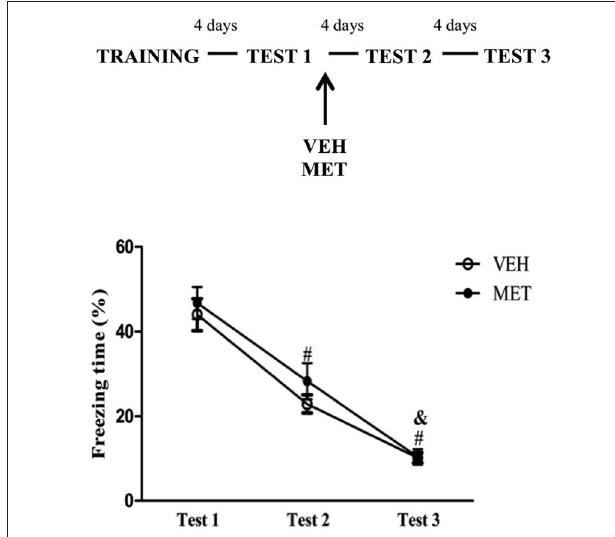
FIGURE 3 | Acute propranolol treatment reduced freezing behavior on Test 1 . Acute propranolol treatment with 2 or 5 mg/kg before Test 1 reduced freezing behavior. PROP 2 = propranolol 2 mg/kg ( n = 8); PROP 5 = propranolol 5 mg/kg ( n = 8); PROP 10 = propranolol 10 mg/kg ( n = 9); VEH = vehicle group ( n = 9). * P < 0.05, compared to vehicle group; # P < 0.05, compared to Test 1, all